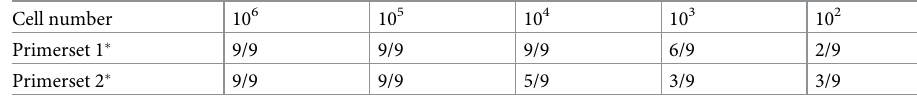
Table 2. PCR-Detection of E . multilocularis 12 rDNA on isolated parasite cells.